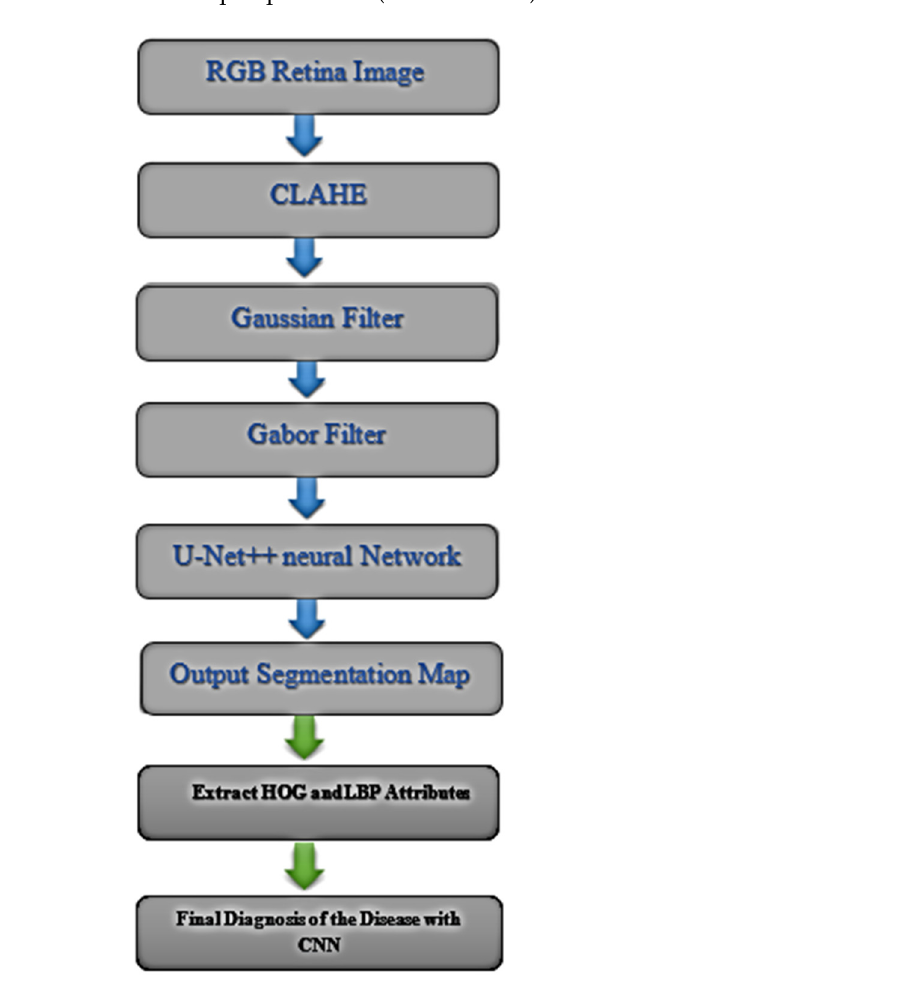
Figure 4. Retinal image segmentation by the U-Net++ neural network and diagnose of disease with a CNN.